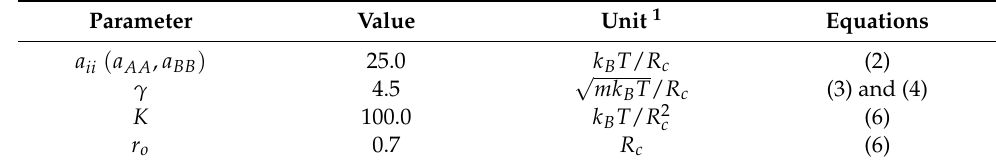
Table 1. The list of the DPD parameters used in the present